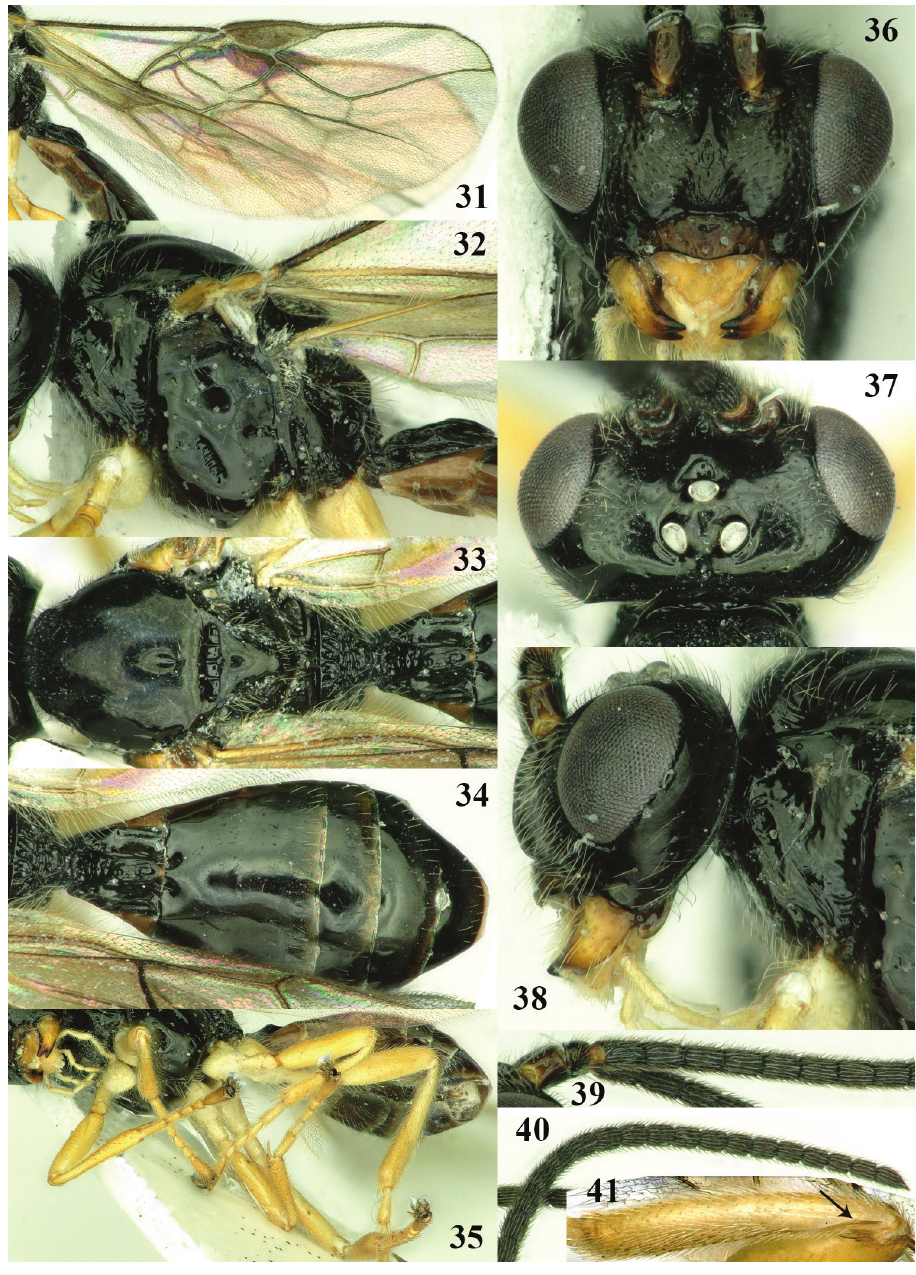
Figures 31–41. Nipponopius glabricaudatus sp. n., ♂ , paratype. 31 wings 32 mesosoma and first meta- somal tergite lateral 33 id. dorsal 34 metasoma dorsal 35 legs antero-ventral 36 head anterior 37 head dorsal 38 head lateral 39 basal antennal segments 40 apical antennal segments 41 inner side of hind tibia lateral (arrow pointing to